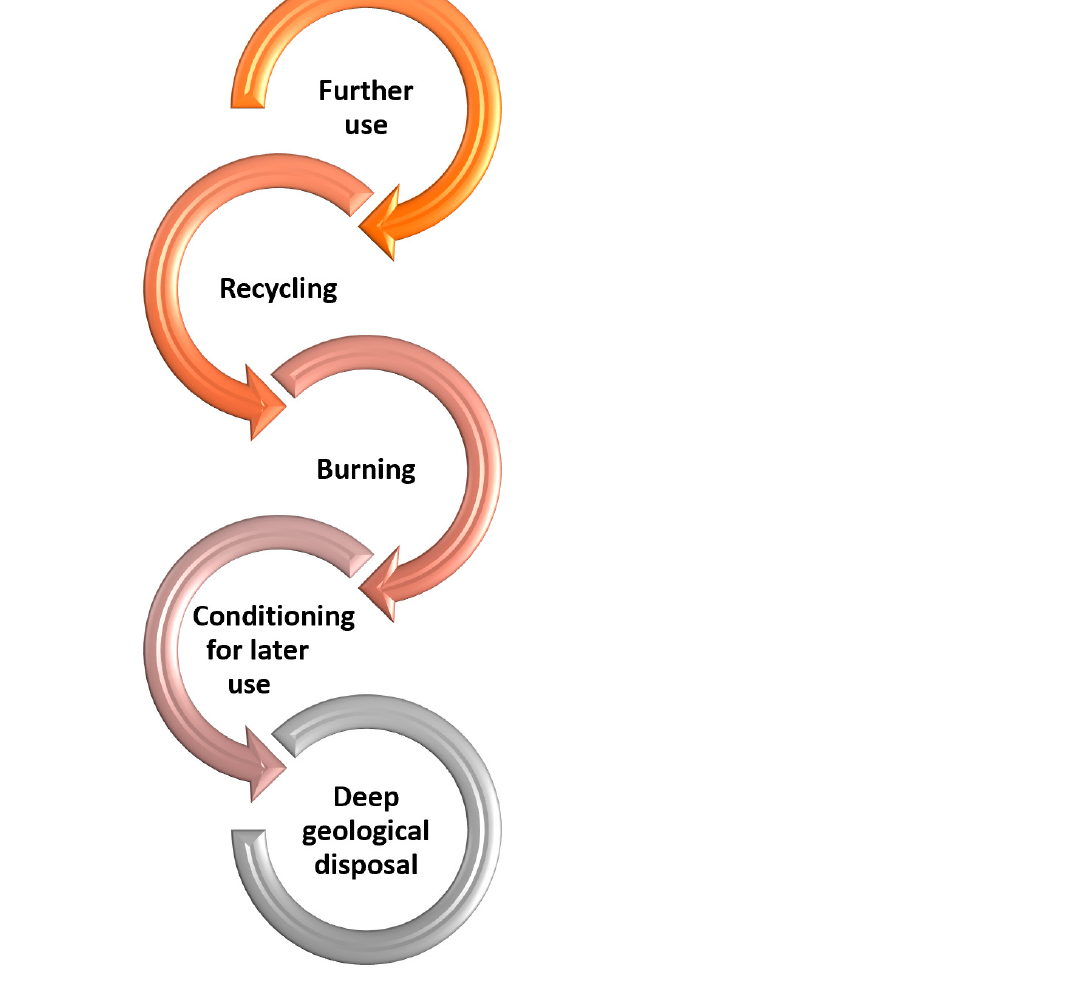
Figure 8. The cascade of potential re-use of materials before these materials should be considered waste needing disposal.